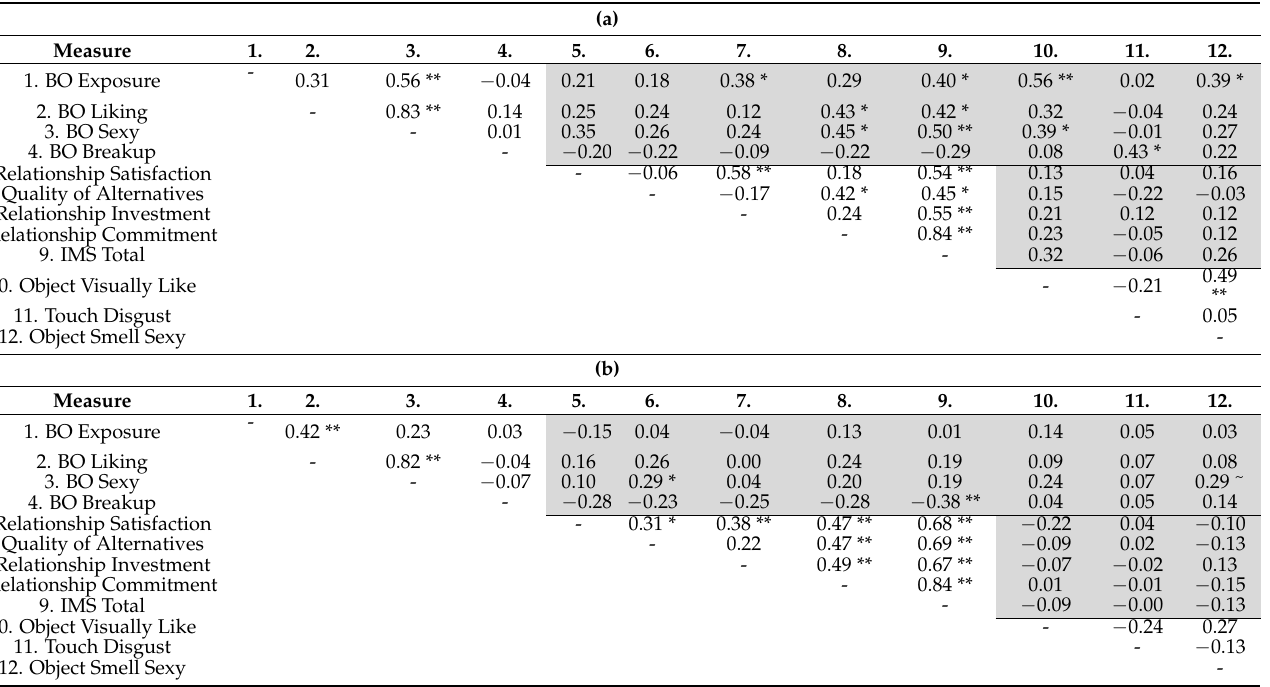
( b ) BO = Body odor. ~ p = 0.052 * p < 0.05, ** p < 0.01. Olfactory ability (measured by TDI) was statistically controlled for using partial correlations (except for within-measure correlations). Cells with correlations between two different measures are grey. IMS = Investment Model Scale. The three different bivariate correlations are demarcated with cell borders. The results for single participants (see ((a) in Table 3) revealed that overall, most of the IMS subscales and the Total score were positively correlated with the subscales of the Exposure to Partner Body Odor survey (EXBO), except for the correlations with the BO Breakup variable. The significant positive correlations found between the IMS Total score and the BO Liking, BO Sexy, and BO Exposure variables indicated that higher degrees of relationship commitment were associated with higher hedonic ratings of partner BOs and lower breakup intentions in response to exposure to unpleasant partner BOs. While a similar pattern of findings was revealed for partnered participants (see ((b) in Table 3), the IMS Total score was not significantly correlated with BO Exposure, BO Liking, or BO Sexy. However, a significant negative correlation was found between the IMS Total score and the BO Breakup variable, indicating that higher ratings of wanting to break up with one’s partner after smelling their unpleasant BOs were associated with lower levels of relationship